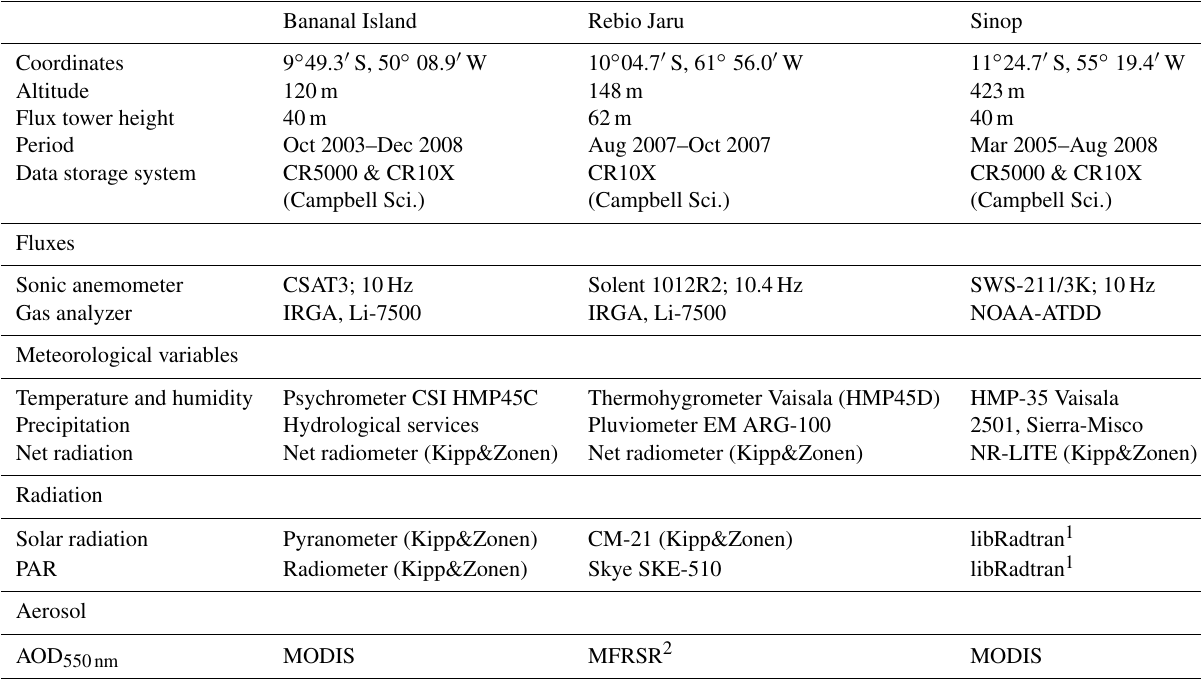
Table 1. Geographic coordinates, altitudes, flux tower height, and the sensors used in the three experimental